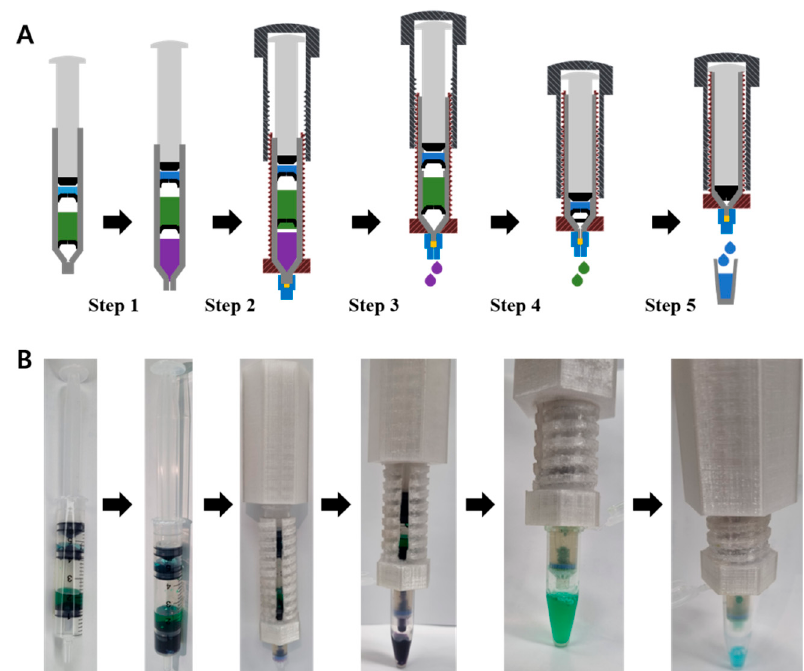
Figure 2. Operation procedure of the syringe-based one-step DNA extraction device. ( A ) Schematic illustration of the DNA extraction procedure using the syringe-based DNA extraction device. ( B ) Photographs of the syringe-based DNA extraction device at each step of the extraction procedure.